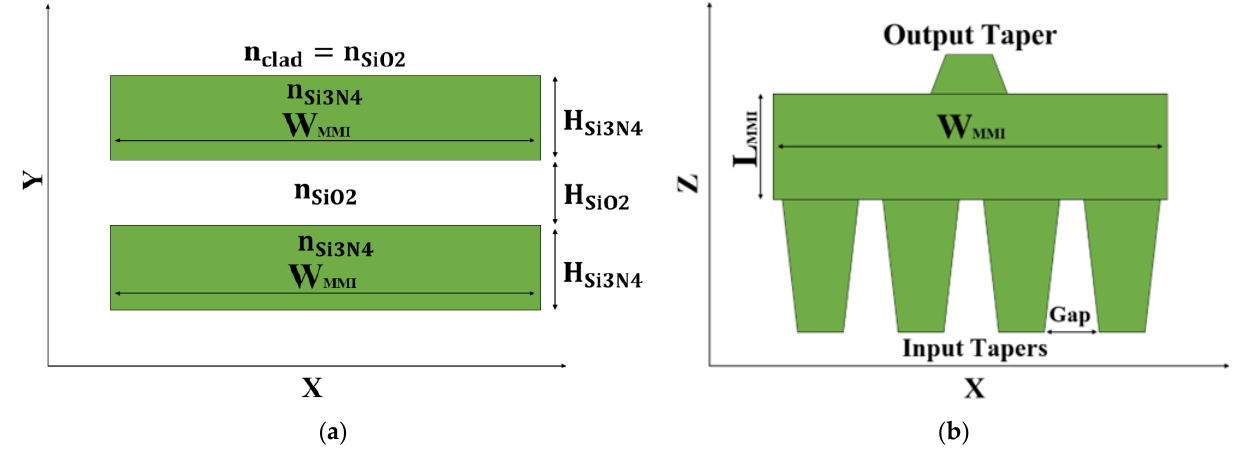
Figure 1. Illustration of the 4 × 1 MMI coupler intensity combiner: ( a ) XY cross-section view. ( b ) XZ cross-section view.